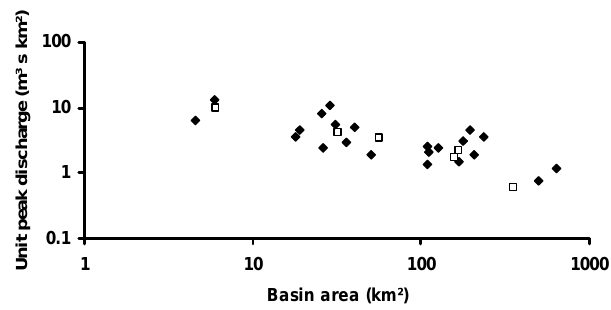
Fig. 7. Relation between the basin area and unit peak discharge for Figure 7. Relation between basin area and unit peak discharge for the studied events and other the studied events and other significant flash floods in significant flash floods in Romania.